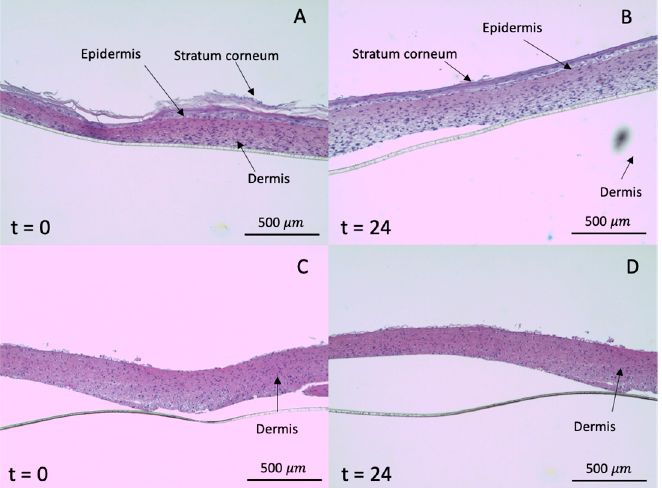
Figure 7. Histological analysis of fixed full thickness skin (containing epidermal and dermal layers, A and B ) and skin equivalents with only dermis ( C and D ) before ( t = 0 h) and after ( t = 24 h) the LID permeation experiment from GMS-LID4 particles in the cellular inserts.